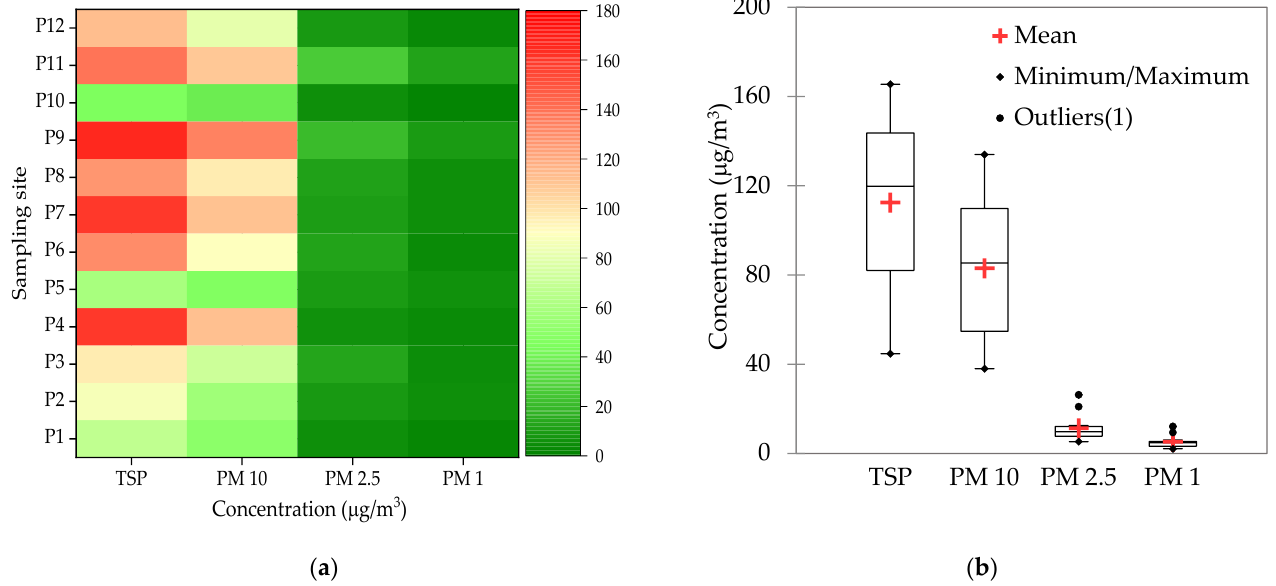
Figure 1. Total suspended particles (TSP), PM 10 , PM 2.5 , and PM 1 in ambient air in the study sites: ( a ) Concentration; ( b ) Minimum, mean, and maximum concentration.